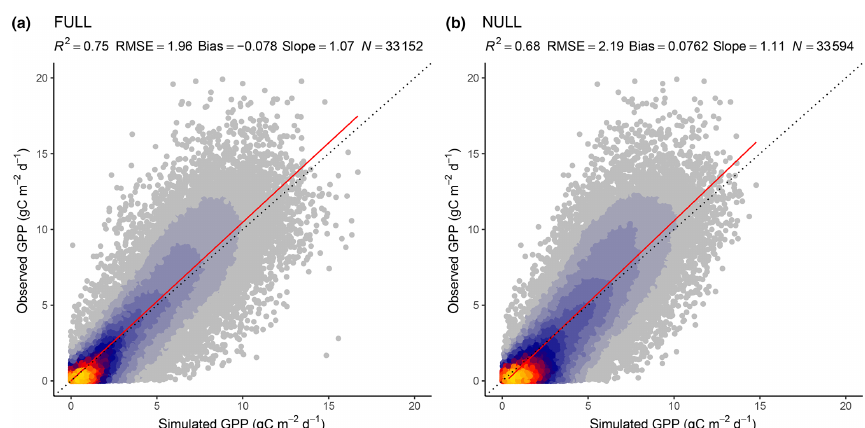
Figure 3. Correlation of observed and modelled GPP values of all sites pooled, mean over 8d periods, for the model setups FULL (a) and NULL (b) .